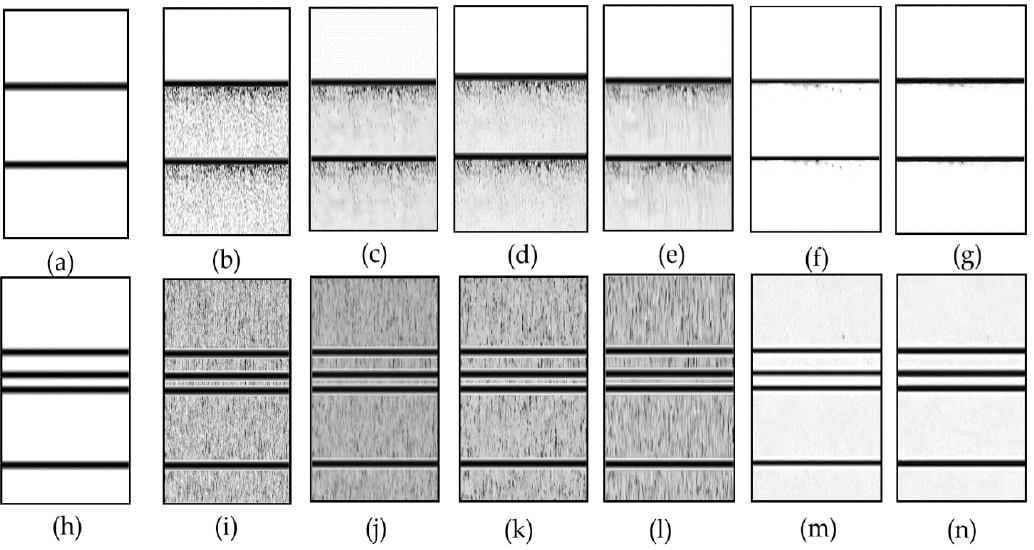
Figure 14. Filtering results based on synthetic data: ( a ) shows the clean synthetic SBP image, ( b ) is the synthetic polluted SBP image, ( c – g ) are the filtered results using KSVD, NLM, BM3D, NLLR, and the proposed method, ( h ) is the clean synthetic SBP image, ( i ) is a synthetic polluted SBP image, ( j – n ) show the filtered results using KSVD, NLM, BM3D, NLLR, and the proposed method. Table 1. Comparison of the different denoising methods applied in Figure 14b. Bold highlights indicate the best results.